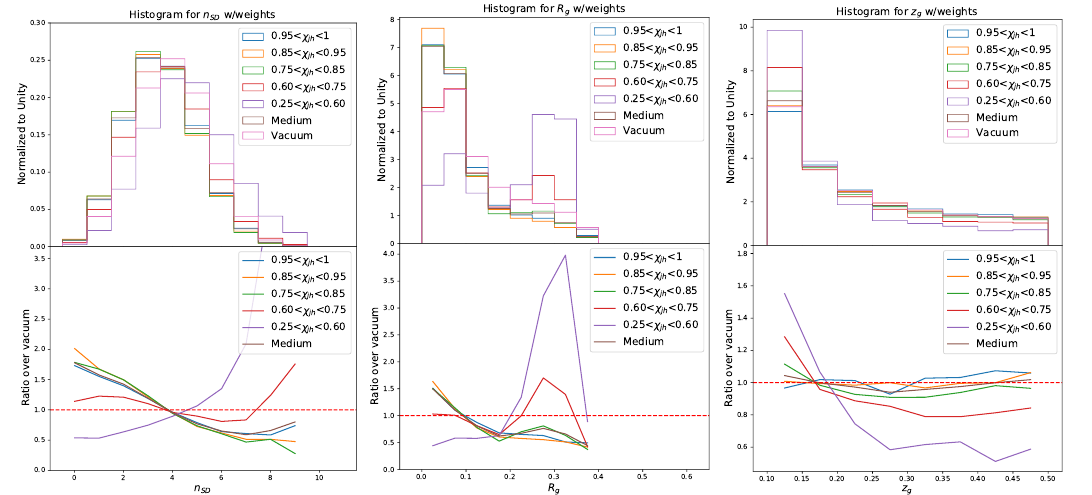
Figure 31 . Histograms of jet n SD , R g and z g inclusive and sliced in χ jh and their ratio over vacuum.